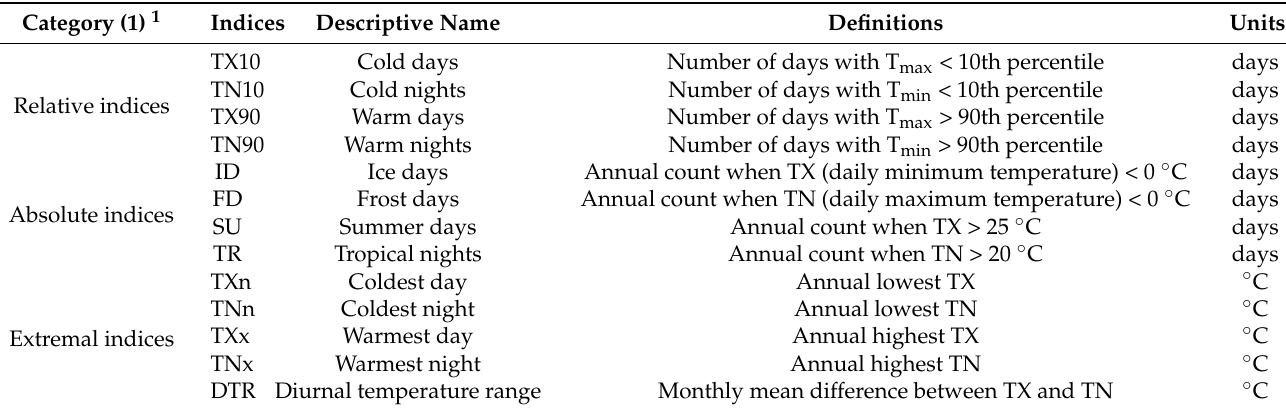
Table 1. 13 Definitions of extreme temperature